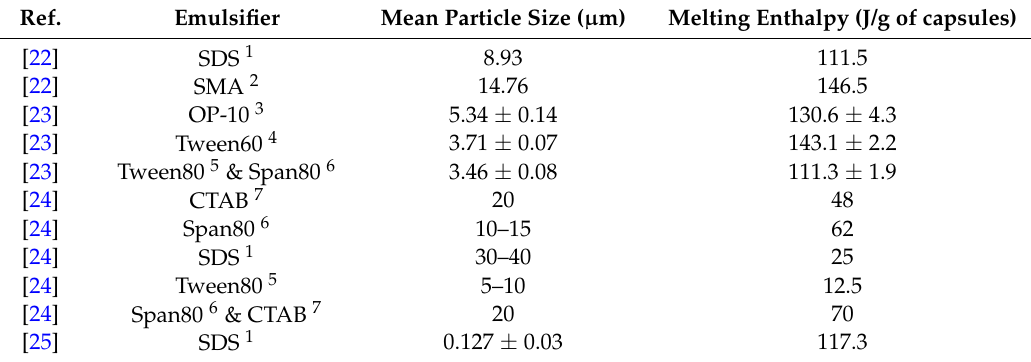
Table 7. The size and melting enthalpy of n -octadecane M-NEPCMs in the literature.